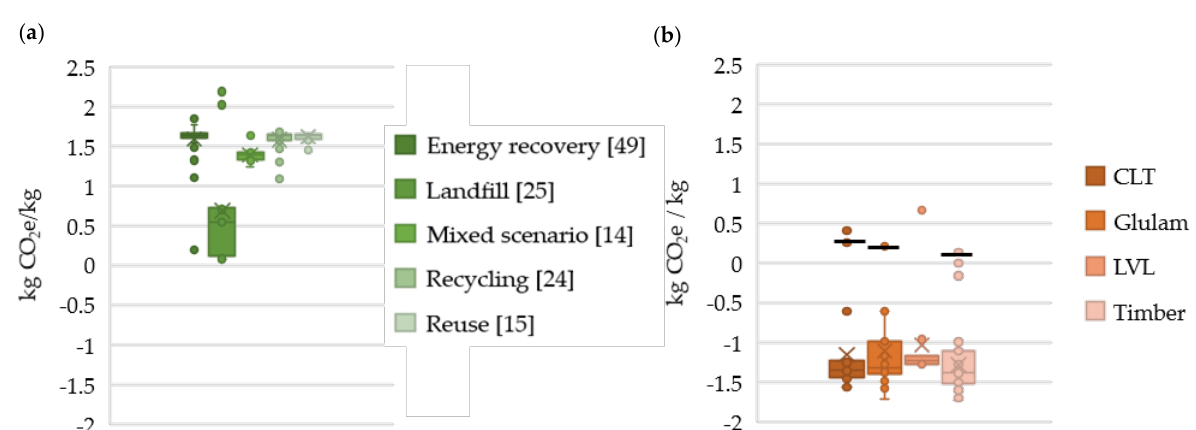
Figure 7. ( a ) Reported GWP in CO 2 e from different EoL options applied in the surveyed EPDs, normalized to impacts per kg of product. The numbers in brackets indicate the number of data points, i.e., relevant product scenarios included. ( b ) Reported GWP in CO 2 e from the different categories of structural wood in the surveyed EPDs, normalized to impacts per kg of product. Black marks show GWP further normalized to exclude biogenic CO 2 .